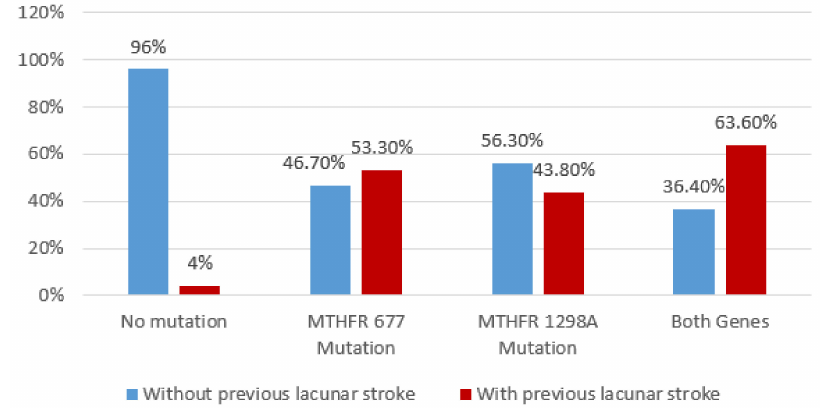
Figure 7. Association between previous lacunar stroke and MTHFR polymorphisms using Chi 2 Test.